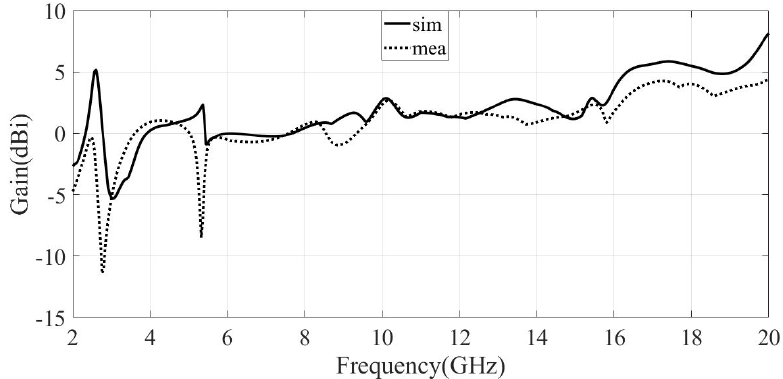
Figure 8. Simulated and measured antenna gain of the proposed